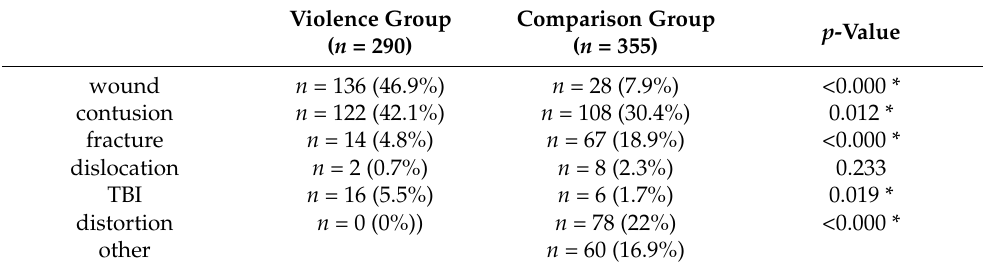
Table 3. Discharge